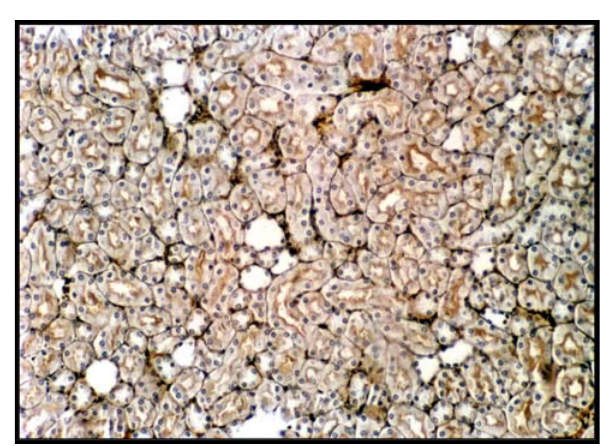
FIGURE 1 - Normal renal interstice and tubules in animal of GC at the time 3 (21 days). PASM,